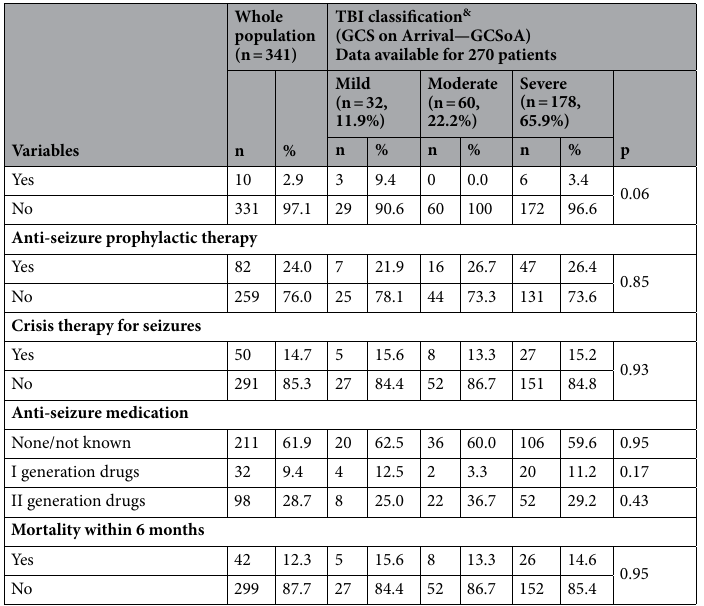
Table 1. Demographic and clinical characteristics of patients with traumatic brain injury (TBI). Data for the whole group and subdivided according to TBI severity (mild, moderate and severe) based on the Glasgow Coma Scale on Arrival (GCSoA). Significant difference are highlighted in